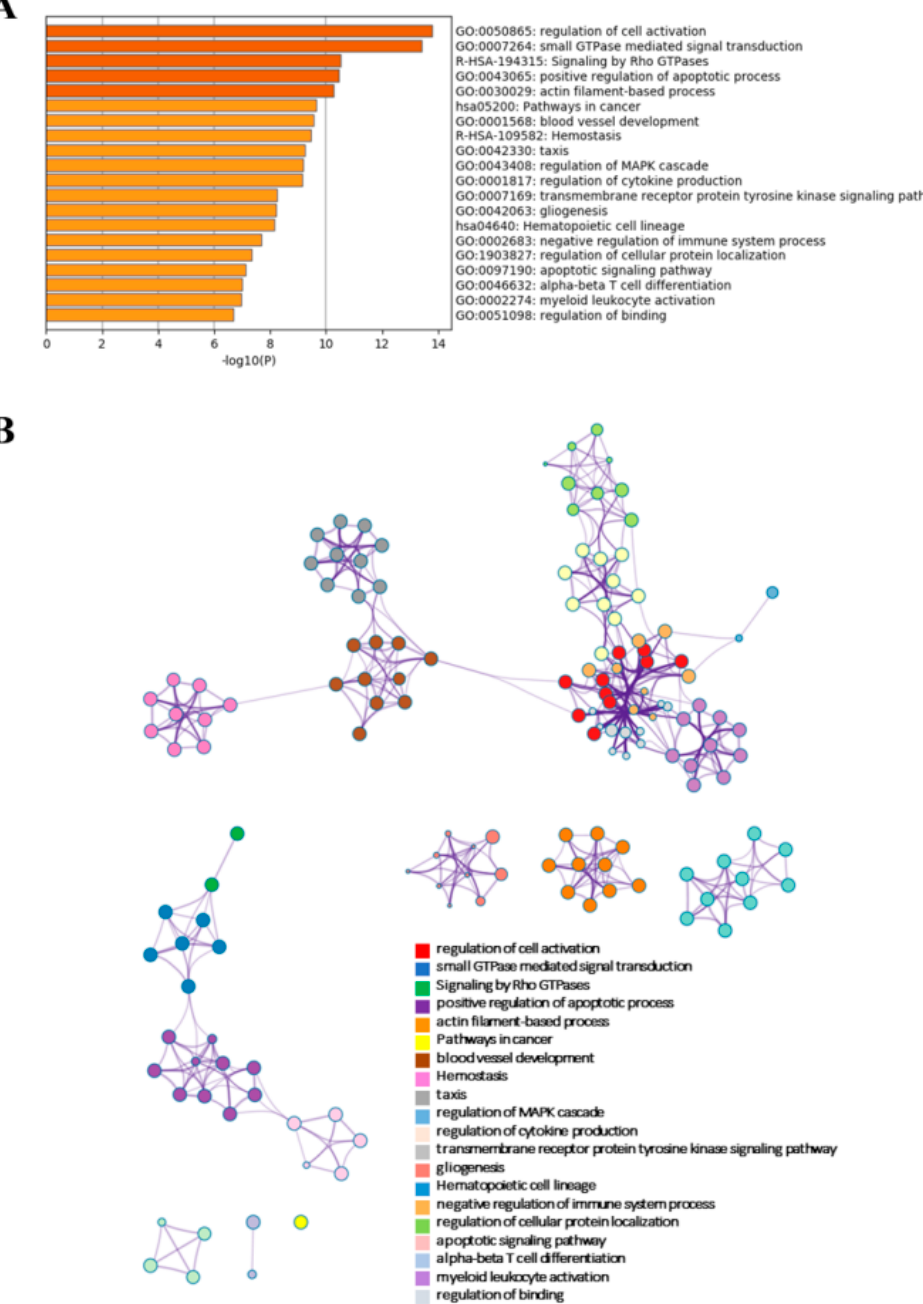
Figure 4. Signalling pathways regulated by protein–coding genes (PCGs) according to Gene Ontology (GO), Reactome and Kyoto Encyclopedia of Genes and Genomes (KEGG) database. ( A ) Top statistically significant enriched signalling pathways ( − log10 p > 6) with accumulative hypergeometric p –values and enrichment factors calculated and used for filtering from overall enrichment analysis. ( B ) Enriched ontology clusters shown as a network only for the subset of representative biological processes ( − log10 p > 6, accumulative hypergeometric p –values) from the full enrichment analysis. Each term is represented by a circle node. Top statistically significant terms are hierarchically clustered into a tree based on Kappa–statistical similarities (score > 0.3) among their gene memberships, linked by an edge (the thickness of the edge represents the similarity score). Each cluster has a colour and term description.